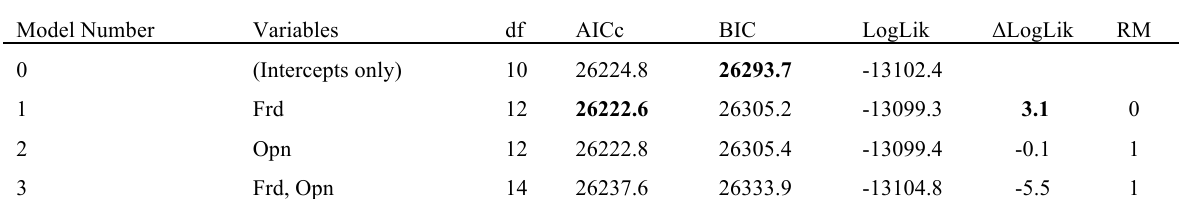
Model Selection Results for Regressions Predicting Progress Variable